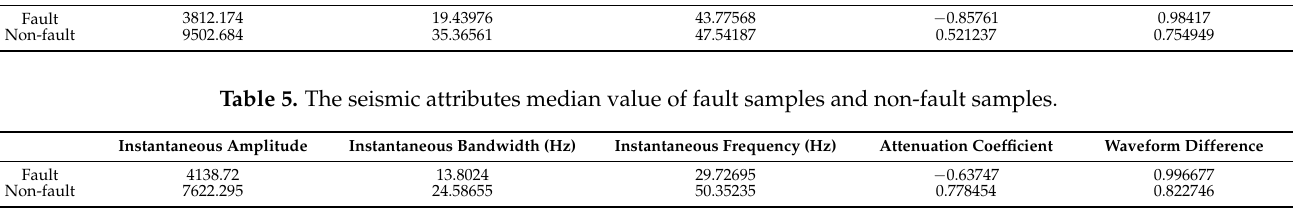
Table 4. The seismic attributes average value of fault samples and non-fault samples. Instantaneous Amplitude